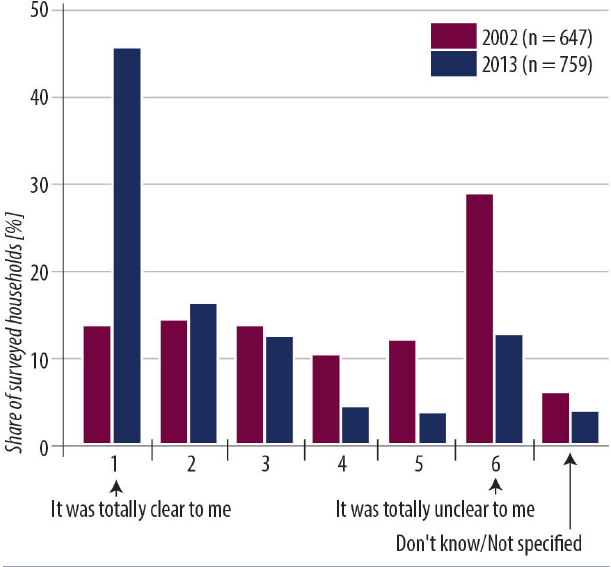
Fig. 4 . Answers of flood-affected residents to the question whether they knew how to protect themselves and their assets from the